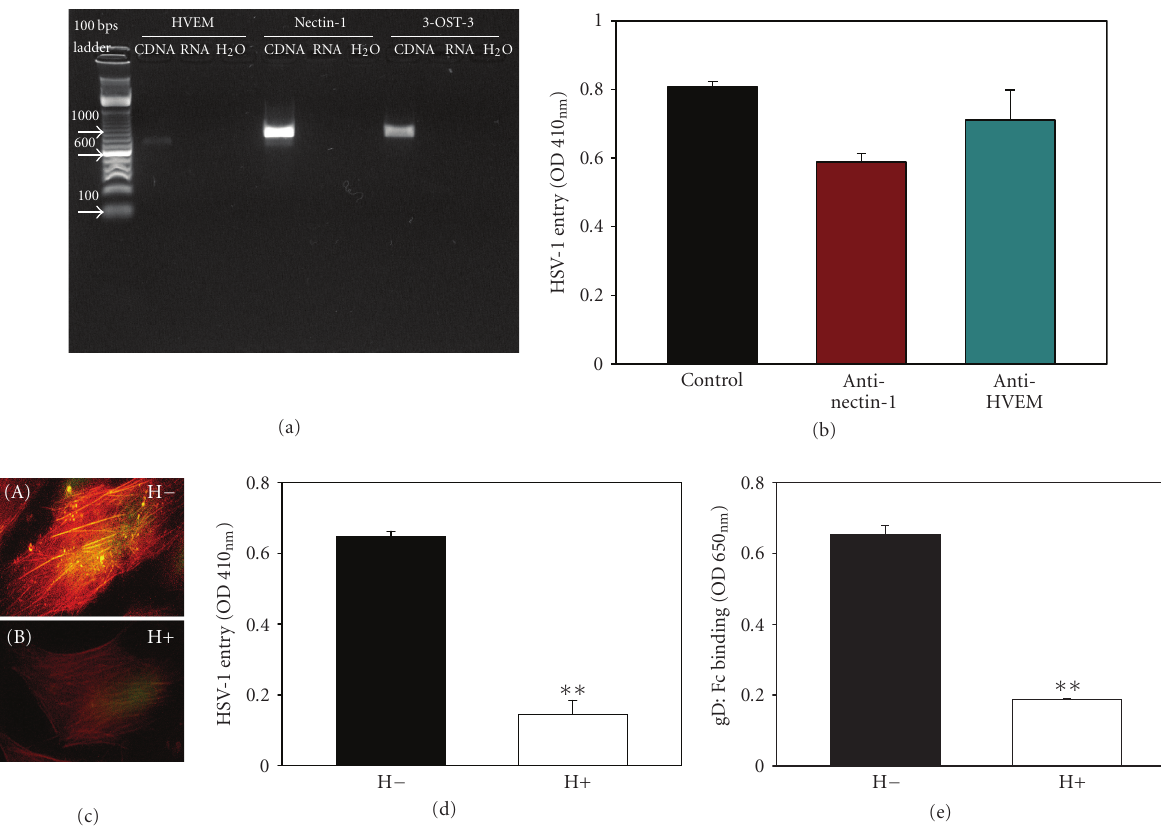
Figure 5: 3- OS HS but not Nectin-1 or HVEM serves as the critical gD receptor in mediating HSV-1 entry into hMSCs. (a) Expression of HSV-1 glycoprotein D (gD) receptors in hMSCs. RT-PCR analysis of nectin-1, 3- O ST-3, and HVEM demonstrated that all 3 genes are normally expressed by hMSCs. No products were detected in the H 2 O or RNA lanes in which H 2 O or the same RNA that was used in generating cDNA templates was used as PCR template to control for potential genomic DNA contamination. The products were separated by electrophoresis on an agarose gel. (b) HSV-1 entry into hMSCs was not significantly a ff ected by anti-nectin-1 or anti-HVEM antibody treatment. Cells were preincubated with anti-nectin-1 and anti-HVEM antibodies (1:10 dilution) followed by infection with reporter HSV- 1 (KOS) gL86 virus. β -galactosidase activity was recorded 6h later to determine HSV-1 entry. The experiment was repeated three times with similar results. (c) Visualization of heparinase treatment on HSV-1 binding into hMSCs. Cultured hMSCs were mock-treated with PBS (H − ) or heparinase I (1.5U mL − 1 ) (H+), followed by exposure to GFP-tagged HSV-1 K26GFP virus at 50 pfu/cell for 30min at 4 ◦ C. Cells were then stained with rhodamine phalloidin that recognizes F-actin (red). Only mock-treated but not heparinase-treated cells showed HSV-1 GFP binding, which appeared yellow when its green fluorescence overlaps with red fluorescence. Virus attachment was determined by using Olympus IX50 inverted fluorescence microscope. (d) E ff ect of heparinase treatment on HSV-1 entry into hMSCs. Cells were treated with heparinase I (1.5UmL − 1 ) (white bar) or mock-treated with PBS alone (black bar), followed by exposure to HSV-1 KOS gL86 at 50pfu/cell. Viral entry was quantitated 6hr later by ONPG assay. Viral entry was reduced more than 3 folds in cells pretreated with heparinase compared to mock-treated cells ( ∗∗ P < . 01, t test). Data shown are the means of triplicate measures. (e) E ff ect of heparinase treatment on HSV-1 gD binding to hMSCs . The cells were either pretreated with a mixture of heparinase-I (treated at 1.5 UmL − 1 ; white bar) or mock- treated (untreated; black bar), followed by exposure to a soluble recombinant form of HSV-1 gD (gD:Fc). Binding of gD:Fc was detected by using HRP-tagged antibody against IgG:Fc and subsequent HRP enzyme detection. Asterisks indicate significant di ff erence from the control treatment ( ∗∗ P < . 01, t test). Error bars represent standard deviation